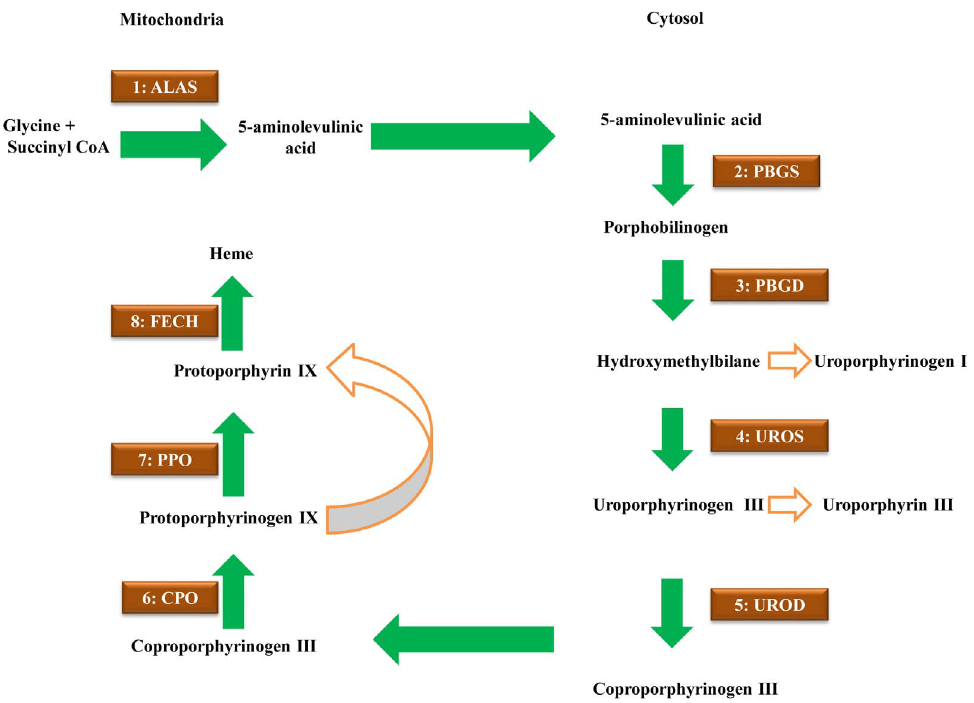
Figure 1. Heme biosynthesis pathway in animals. The substrate and product are indicated for each enzyme and the subcellular localization of each enzyme is also shown (cytosol or mitochondria). Each enzyme is coded from one to eight according to the linear order of the pathway. Also shown are the processes by which hydroxymethylbilane, the substrate of UROS, can be non-enzymatically cyclized to form uroporphyrinogen I, leading to uroporphyrin I or coproporphyrin I, and the process by which uroporphyrinogen III, the product of UROS, can be auto-oxidized to form uroporphyrin III. Protoporphyrinogen, the substrate of PPO, can be auto-oxidized to form protoporphyrin.